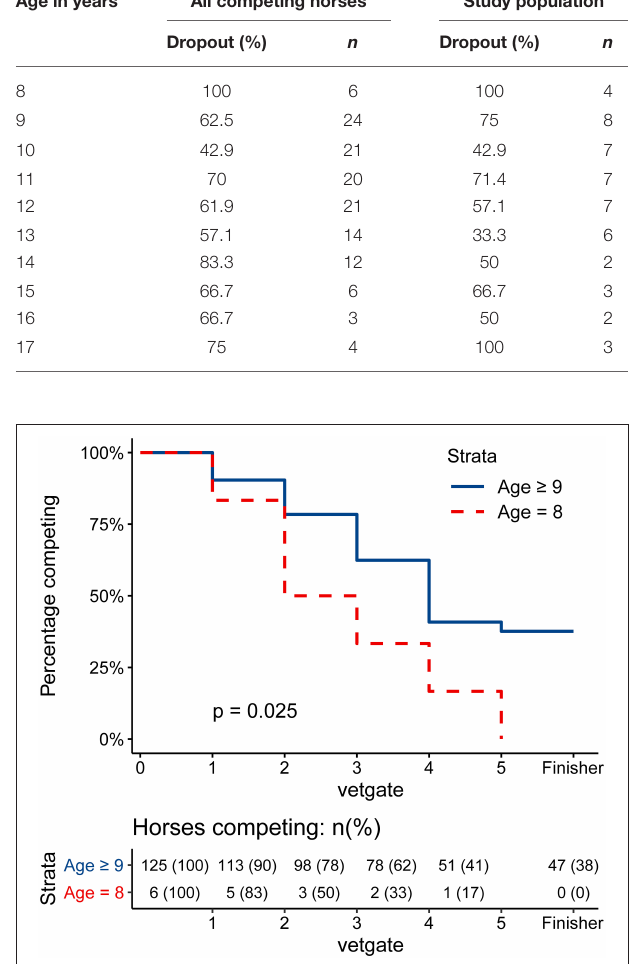
FIGURE 1 | Survival Curve of the Elimination of 8-year-old horses vs. ≥ 9-year-old horses. Kaplan-Meier-Curve of the elimination of 8-year-old horses (red, dashed) and ≥ 9-year-old horses (blue, solid). The gate of elimination was used as the time point. Finishing horses were censored at gate 5 and are visually shown as a extra time point “Finisher.” P -value was calculated using a log-rank test. 8-year-old horses had a significantly higher hazard for elimination ( p = 0.025) compared to ≥ 9-year-old